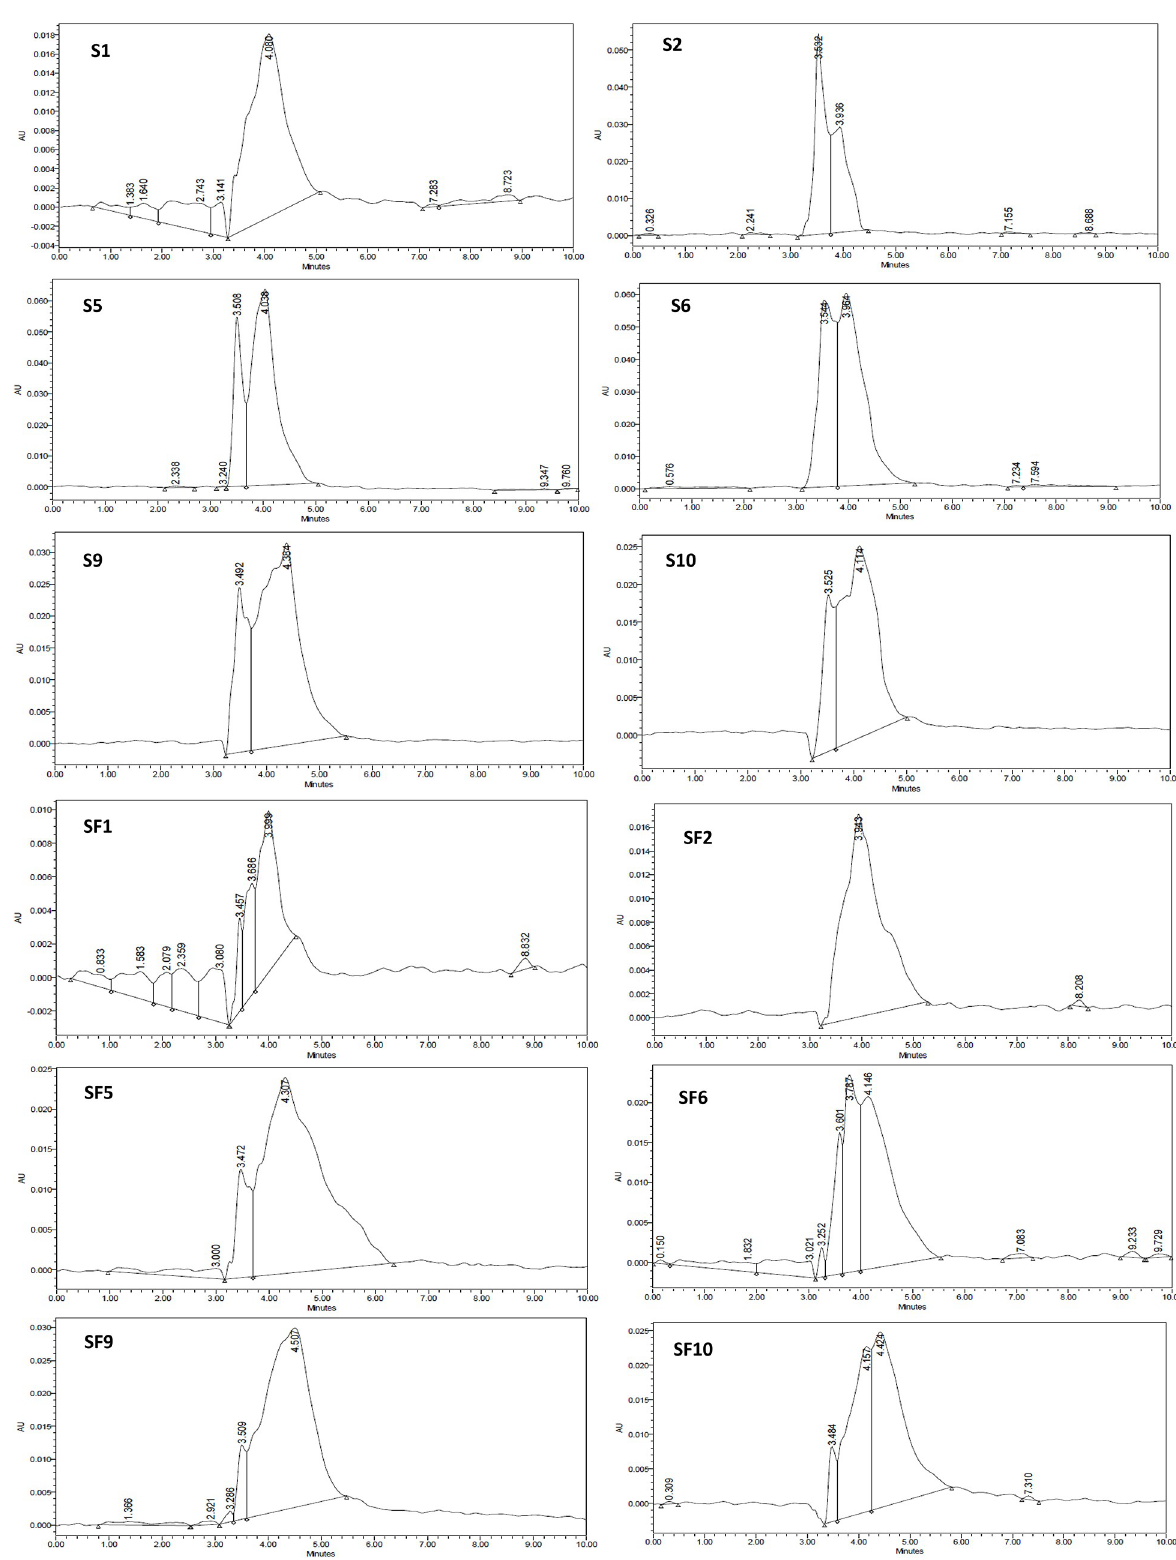
Fig 10. UPLC chromatograms for all of the samples, each heating or frying hour.